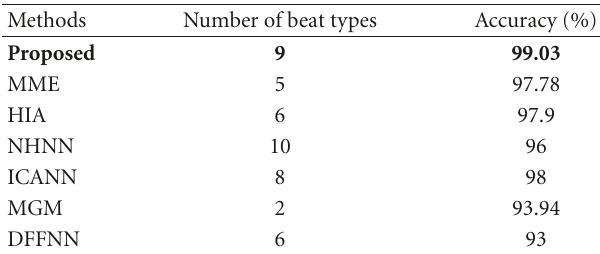
Table 4: Comparative results of di ff erent ECG beat classification